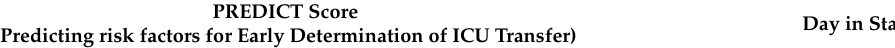
Figure 4. PREDICT score population construction repartition during the first two days of hospitalization, with maximum Youden index value (Cut-off). SMU: standard medical unit. SToi: need intensive care unit (ICU). Table 7. PREDICT score calculation table for the transfer to intensive care unit (ICU). Calculate Day 0 score by a simple sum. Day 1 score is the sum of Day 0 score plus day 1 biological potential point plus following adjustment 1 or 2. Finally, Day 2 score is the sum of day 1 score plus day 2 biological potential point plus following adjustment 1 or